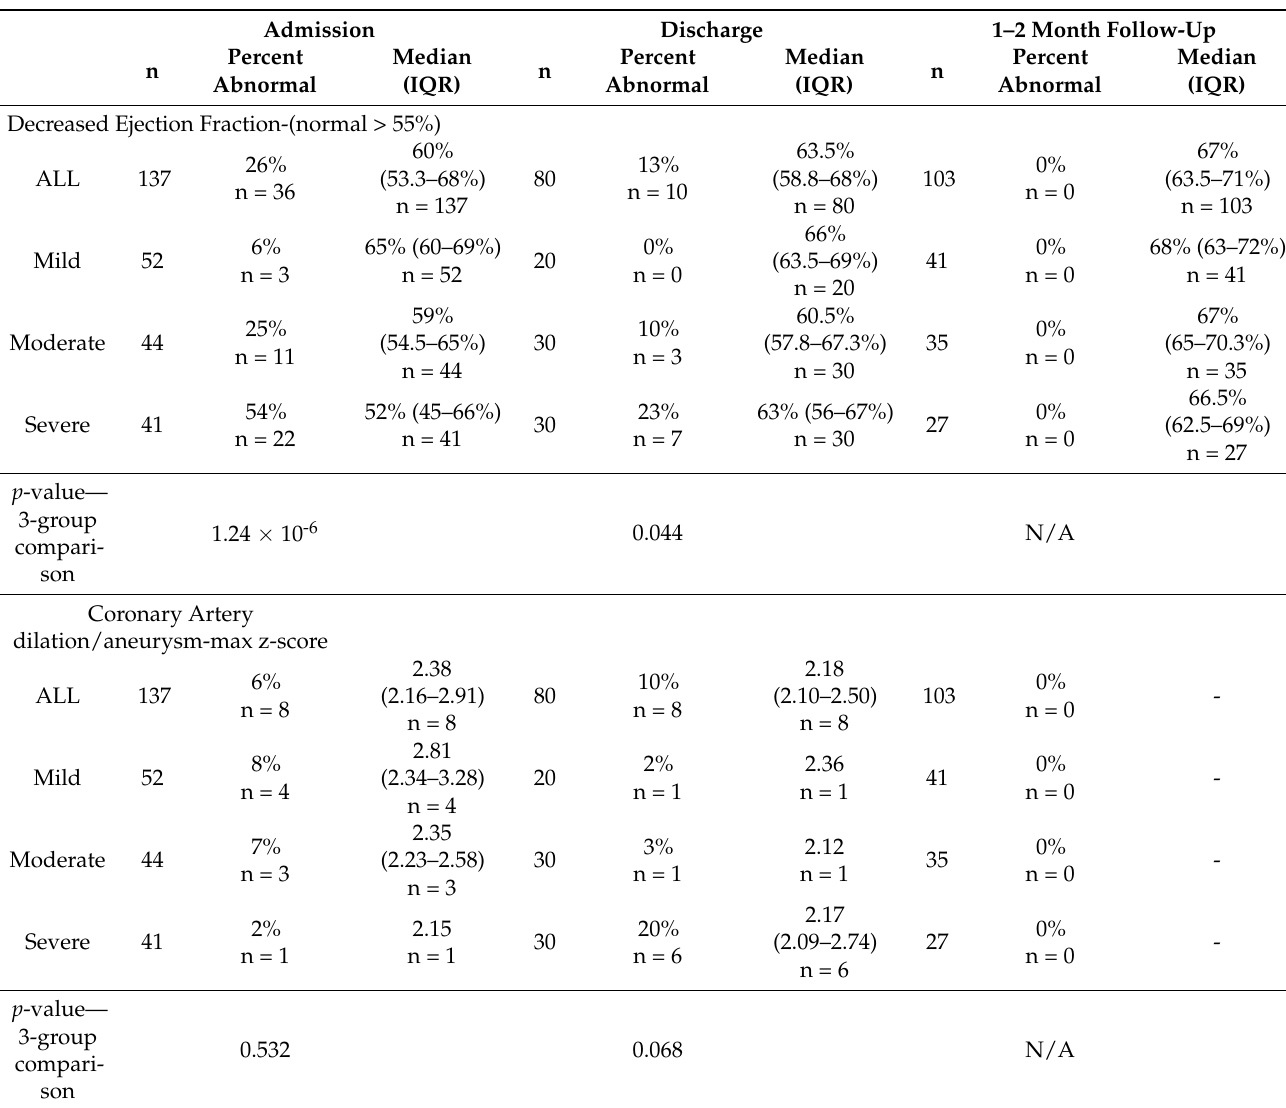
Table 4. Cardiac